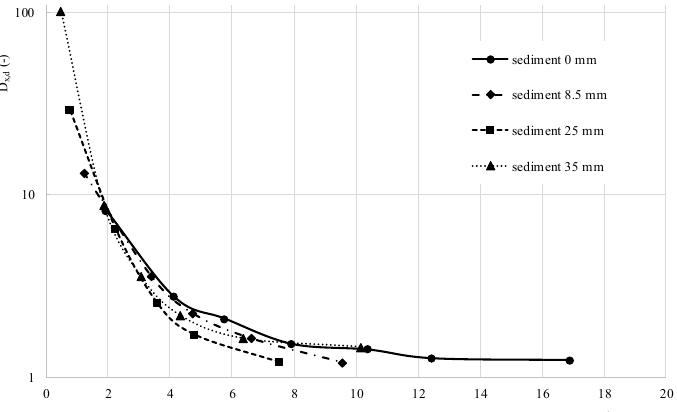
Figure 6. Relationship between D x and Re from tracer experiments results. D x is evaluated according to Gaussian approximation function (Equation (3)).